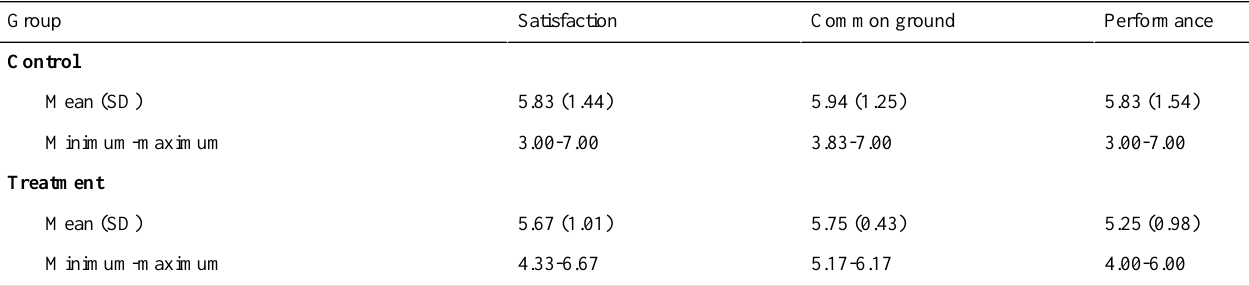
Table 9. Descriptive statistics for the posttest questionnaire